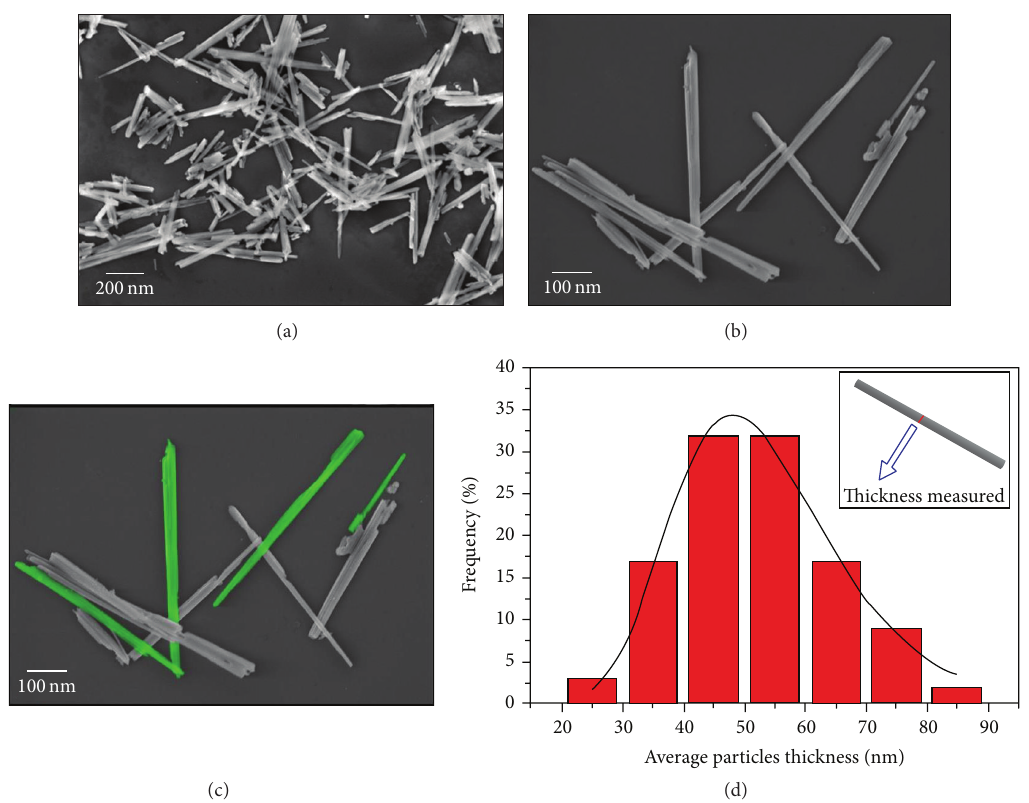
Figure 4: FE-SEM micrograph (a, b, and c) and (d) average distributions of the particle width for 𝛼 and 𝛽 -NiMoO 4 nanostructures.